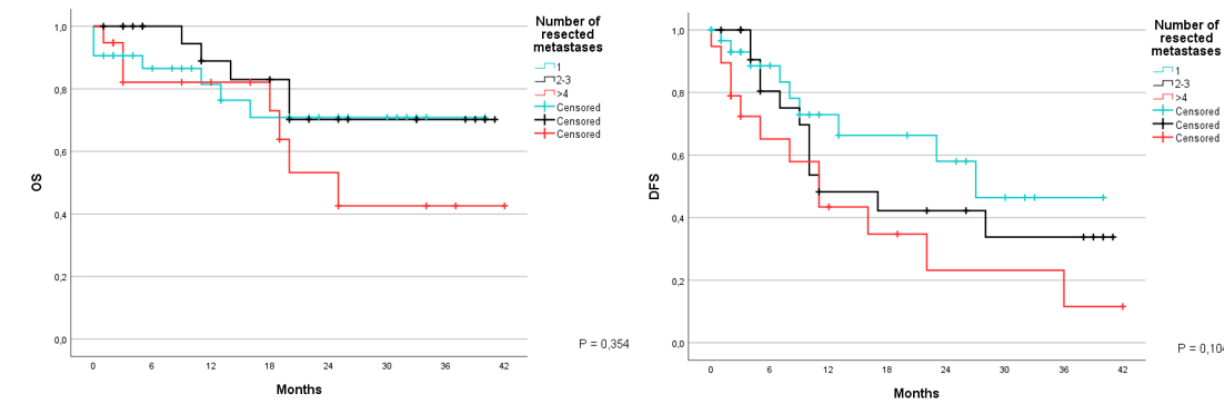
Figure 10. Kaplan-Meier Curve for OS and DFS in patients who underwent liver resection for CRLM stratified according to number of lesions removed. OS: Overall Survival; DFS: Disease Free Survival; CRLM: Colorectal liver metastasis.